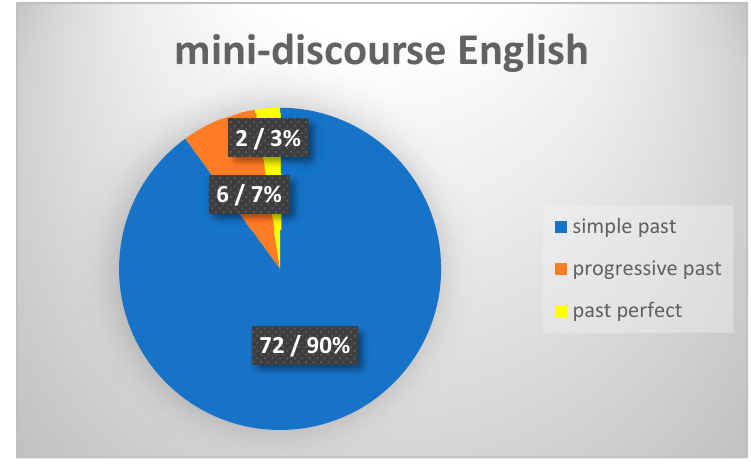
Figure 5. Distribution of English past forms in corpus C (mini-discourse).